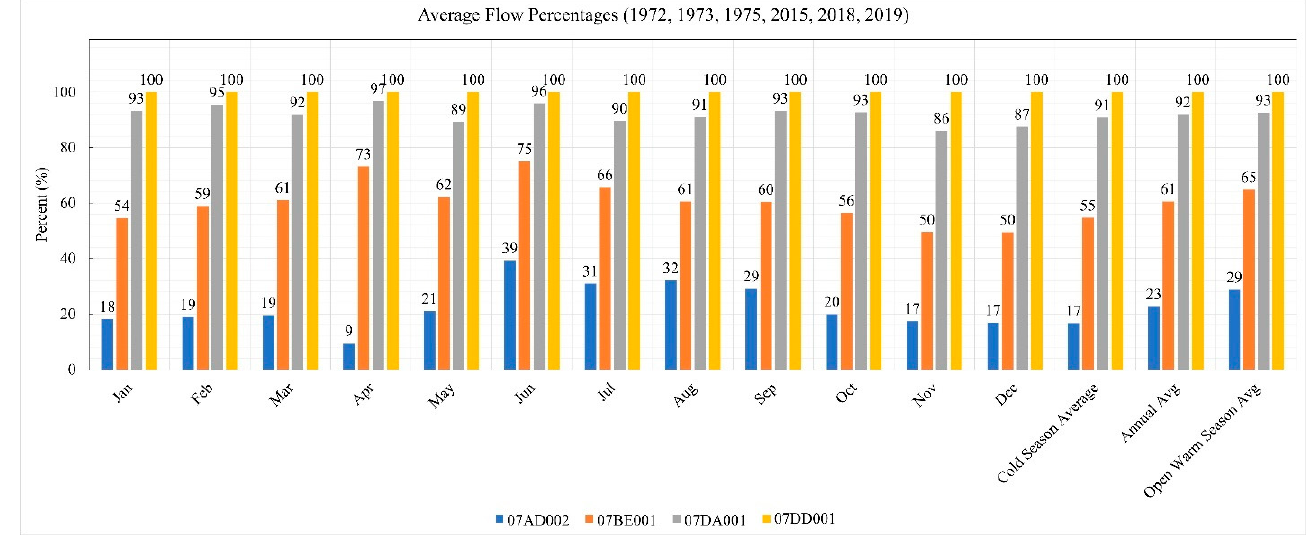
Figure 8. Average flow percentages of hydrometric stations at Hinton, Athabasca, below Fort McMurray, and Embarras Airport for the years 1972, 1973, 1975, 2015, 2018, and 2019 .